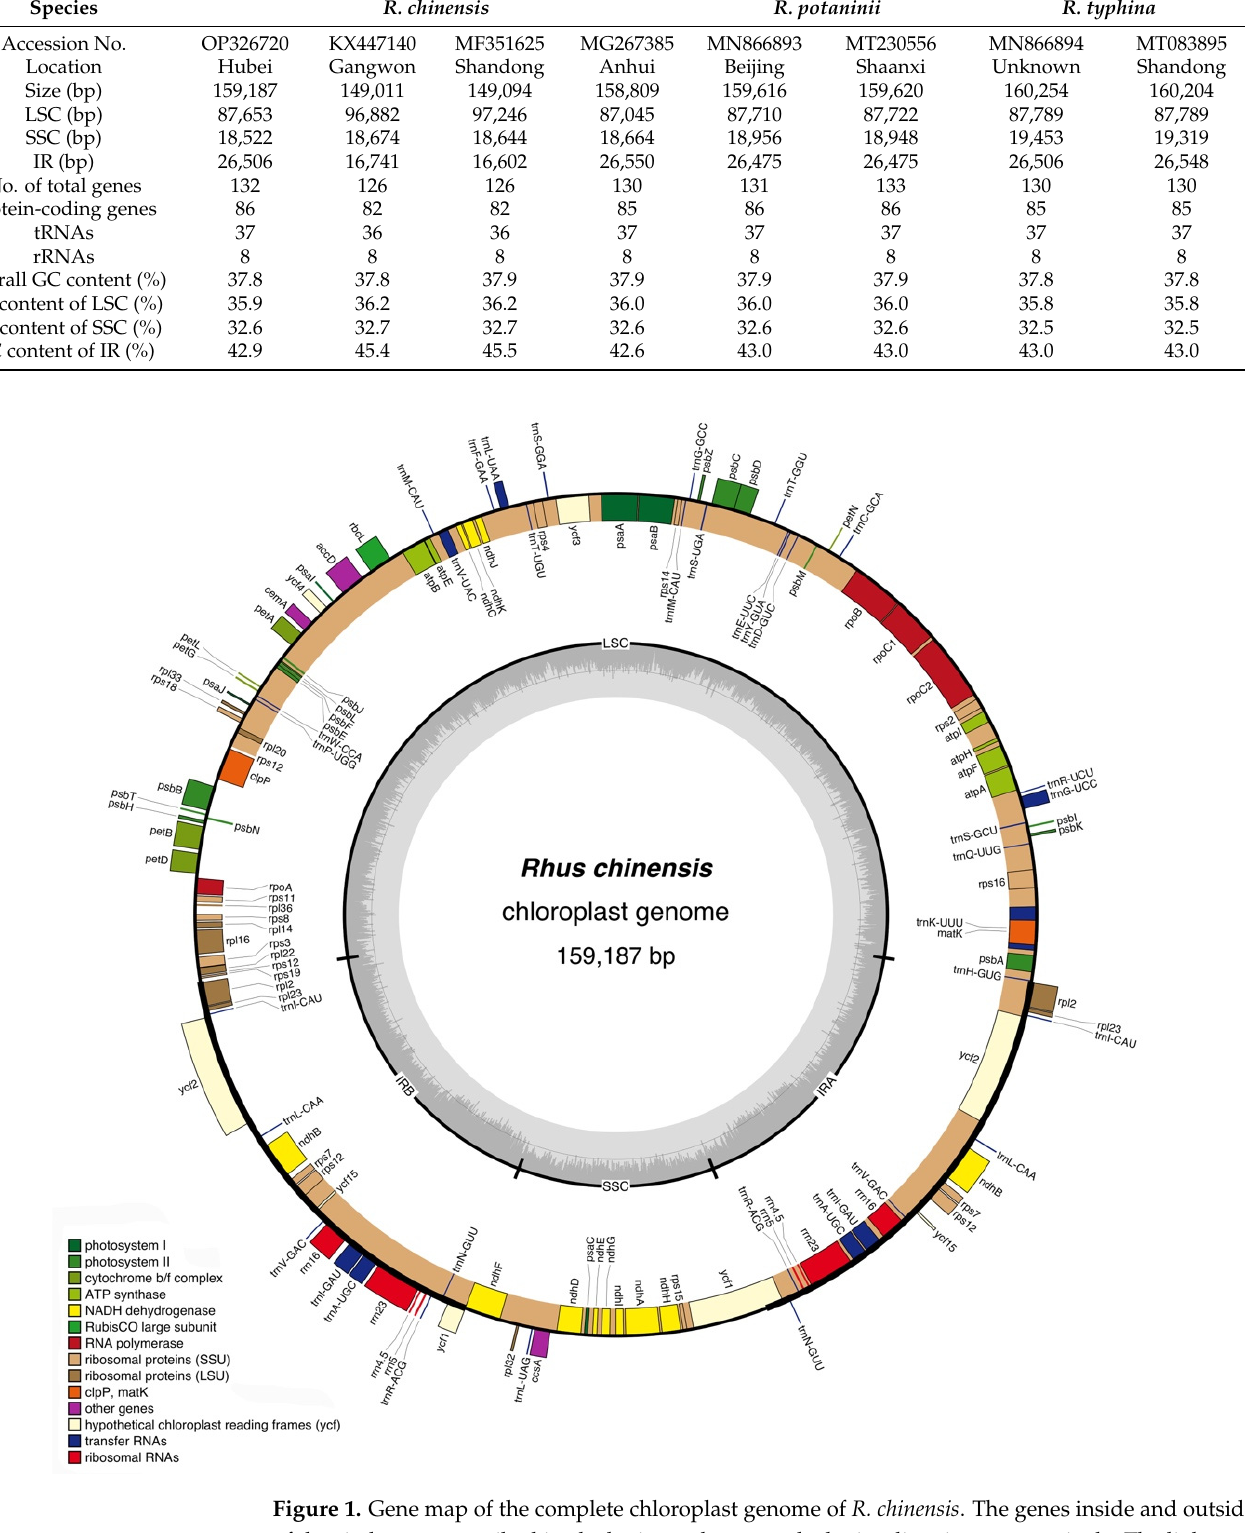
Table 2. Characteristics of the complete chloroplast genomes of Rhus species.